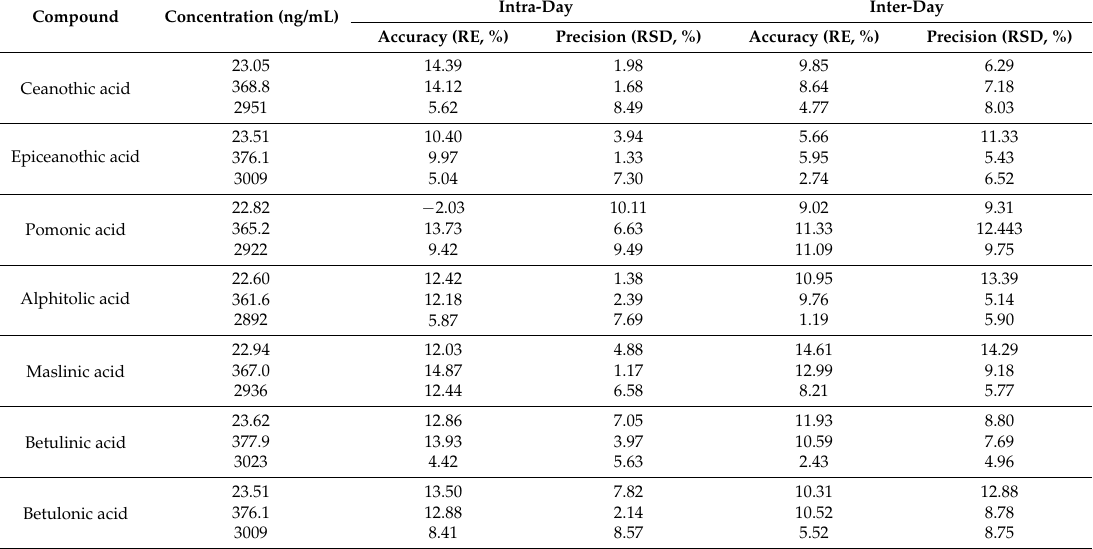
Table 2. Precision and accuracy for the determination of the seven